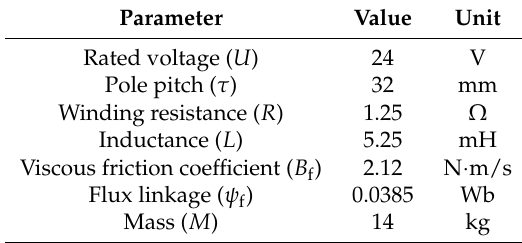
Table 1. Parameters of the permanent magnet linear synchronous motor (PMLSM).